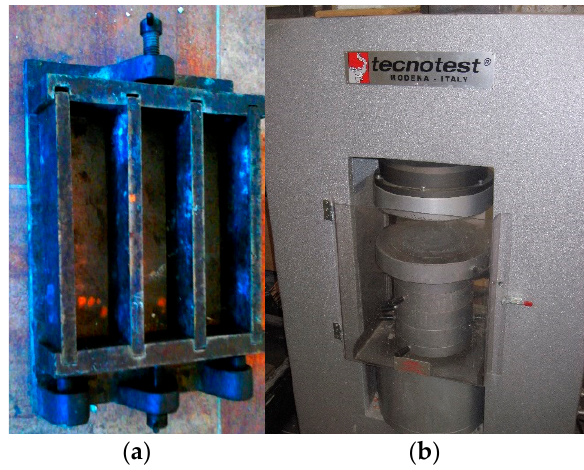
Figure 8. Form and method of sample preparation for laboratory testing of silicate products: ( a ) a three-chamber form for laboratory tests of sand–lime products; ( b ) hydraulic press for laboratory tests of compressive strength.